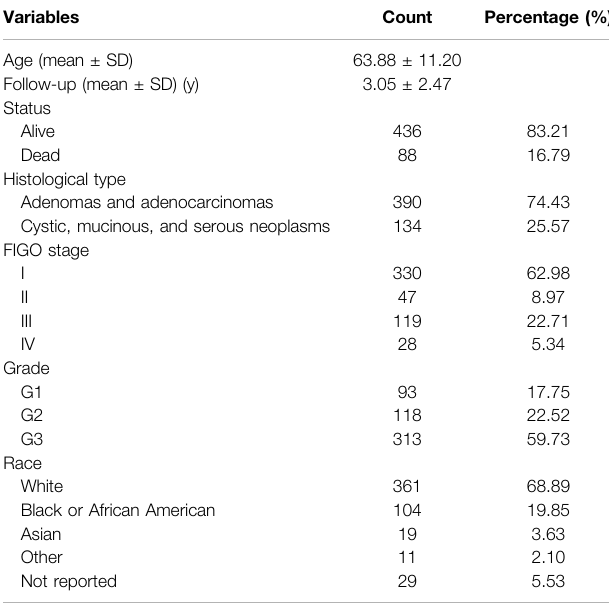
TABLE 1 | The key demographic, clinical, and pathological characteristics of the 524 patients with UCEC.